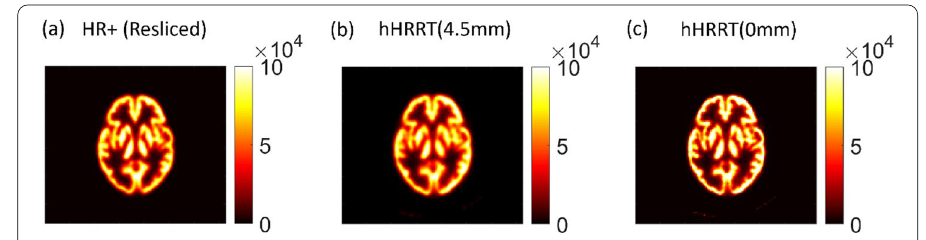
Fig. 1 PET images of the Iida phantom filled with F-18 solution a HR hHRRT(4.5 mm), and c hHRRT(0 mm). All hHRRT images were down-sampled to match the HR Units on the color bars are in